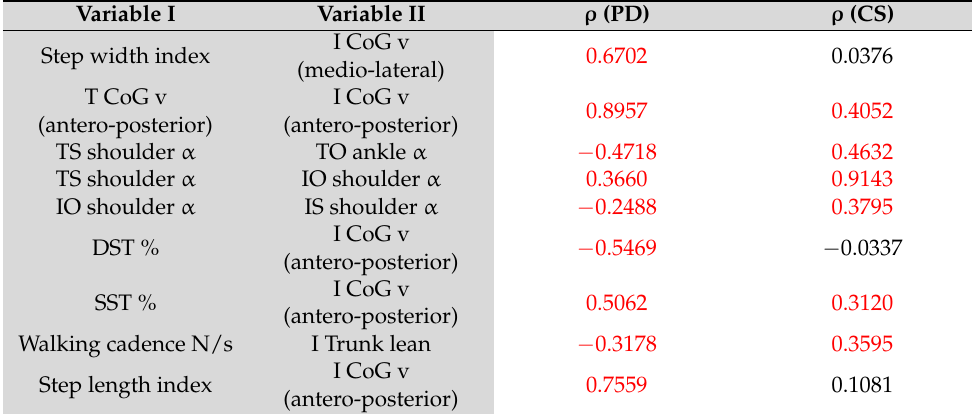
Table 2. Selected Spearman correlations in PD and